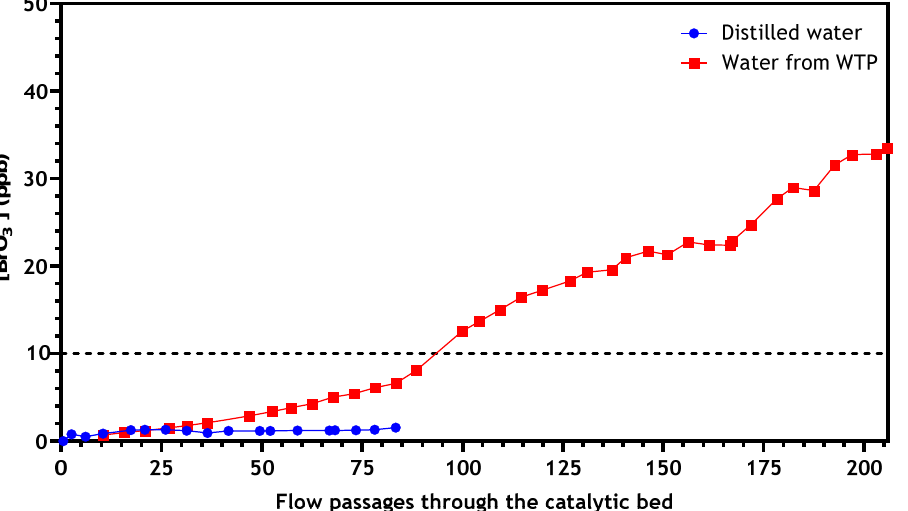
Figure 8. Bromate concentration (ppb) during continuous hydrogen reduction over the catalyst 1 wt.% Pd/MWCNT-O mixed with 0.500 mm carborundum under H 2 using distilled water and water from a water treatment plant. (Q = 7.8 mL min − 1 , 200 mg CAT , H 2 = 12.5 cm 3 min − 1 , C (BrO 3 − ) = 200